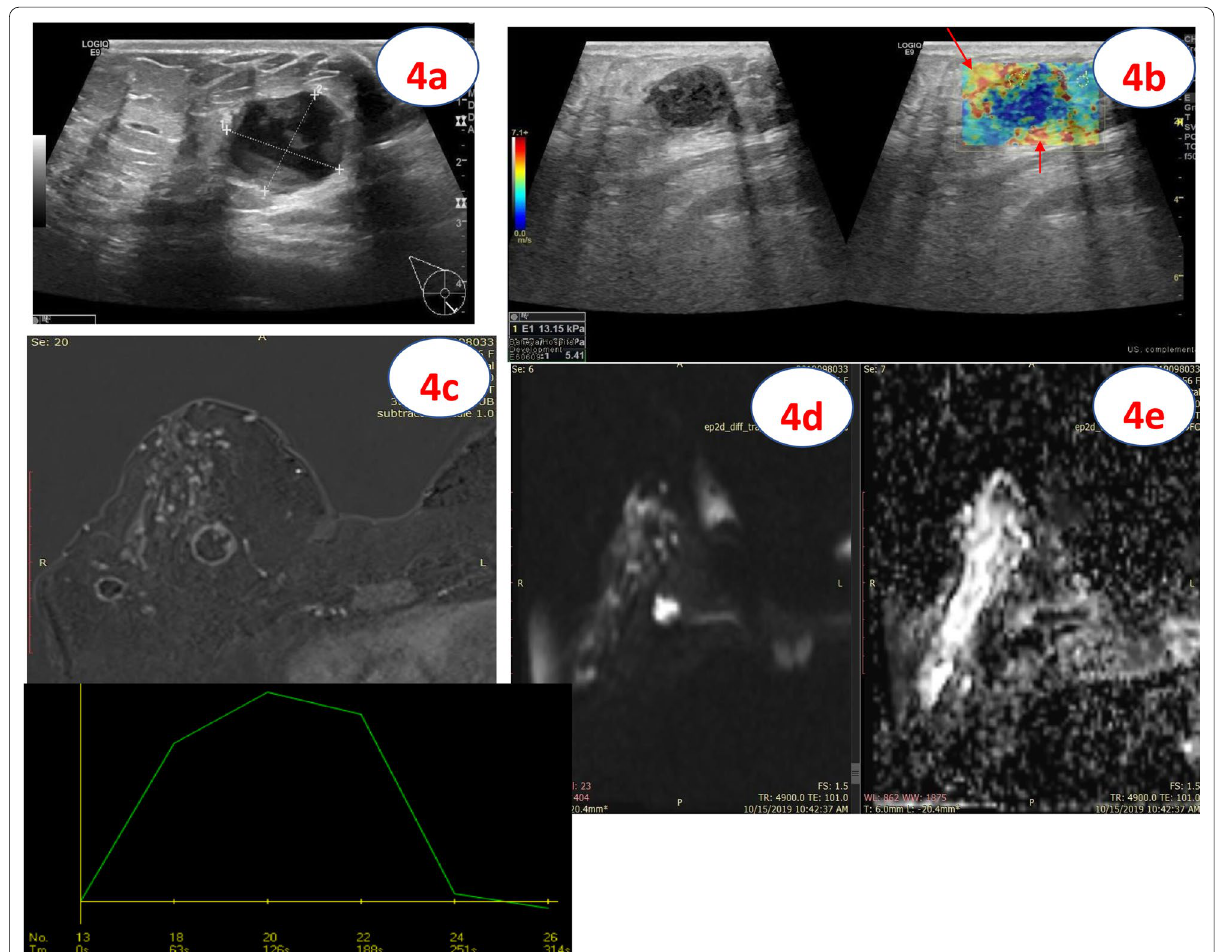
Fig. 4 A 63-year-old female patient, presenting with a right breast lump. a US showed a right lower inner quadrant. Thickened wall, complex cystic lesion (BIRADS 4). b SWE showed that although the red/hard areas of the lesion occupied < 50%, yet low elasticity of the surroundings was noted (red arrows), suggesting an infiltrative process and the lesion was thus considered as suspicious. The measured Emax was 71kPa and Eratio was 5.4 (considered as malignant). c CE MRI showed irregular rim enhancement with a wash out kinematic curve. d , e DE-MRI showed restricted diffusion, with an ADC value of 1.8 10 3 mm 2 /s. Pathology confirmed the malignant nature of the lesion (ADC value showed a false negative result) × ×